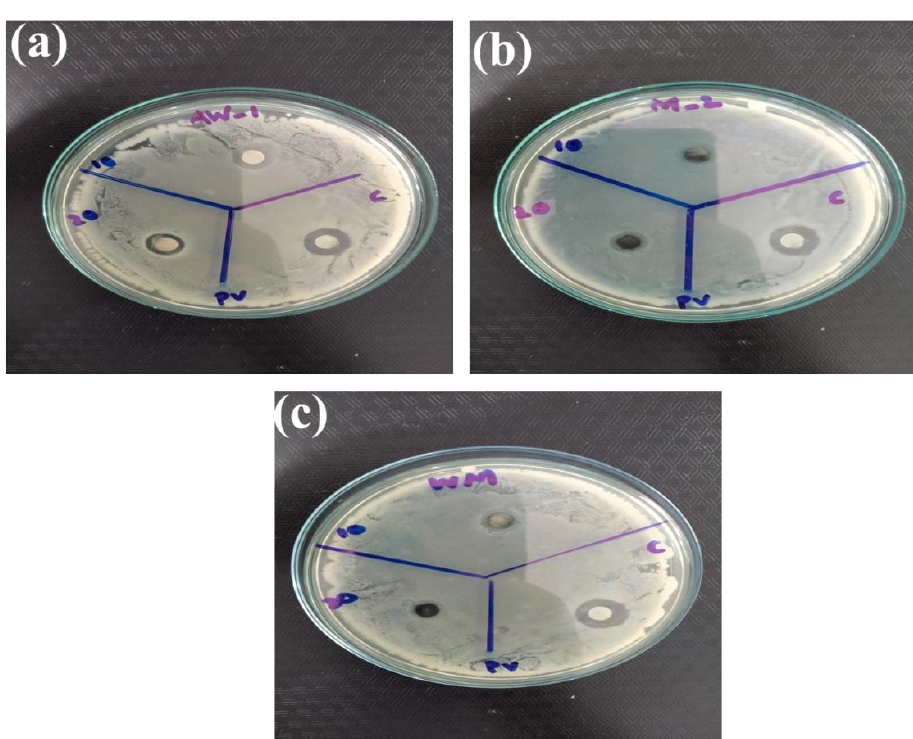
Figure 16. Antibacterial activity of as prepared materials ( a ) WO 3 , ( b ) Mxene and ( c ) WO 3 /Mxene against Proteus vulgaris (P. vulgaris ).